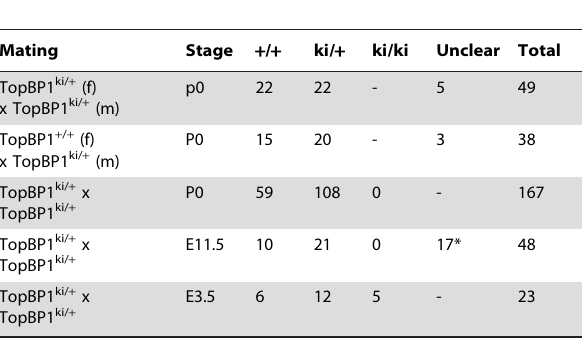
Table 1. Genotype distribution of offspring from TopBP1 ki/ +